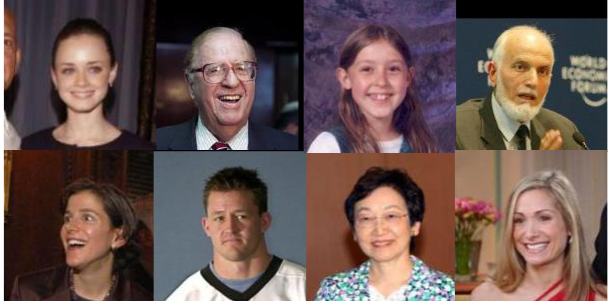
Figure 8. Sample images from the Labeled Faces in the Wild (LFW) dataset.